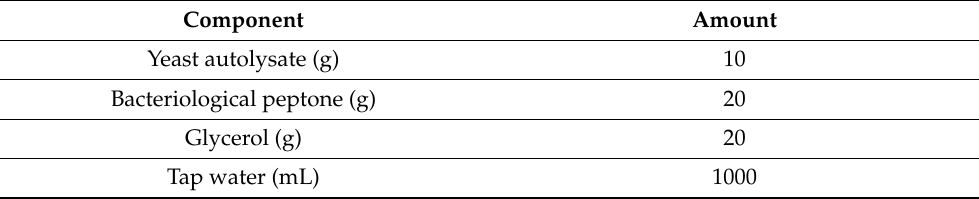
Table 4. YPD media composition.